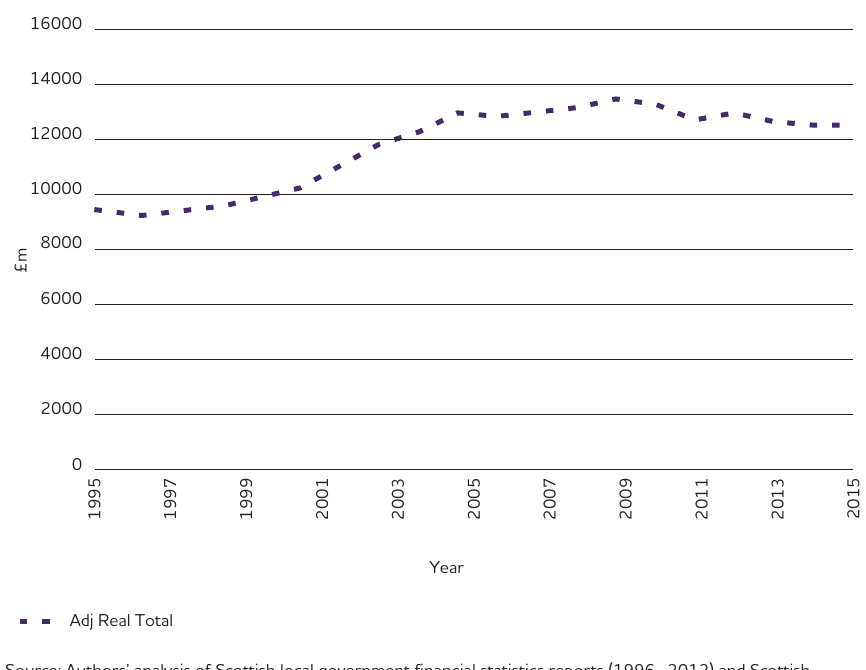
Figure 8: Adjusted Real Total Local Government Spending, Scotland,